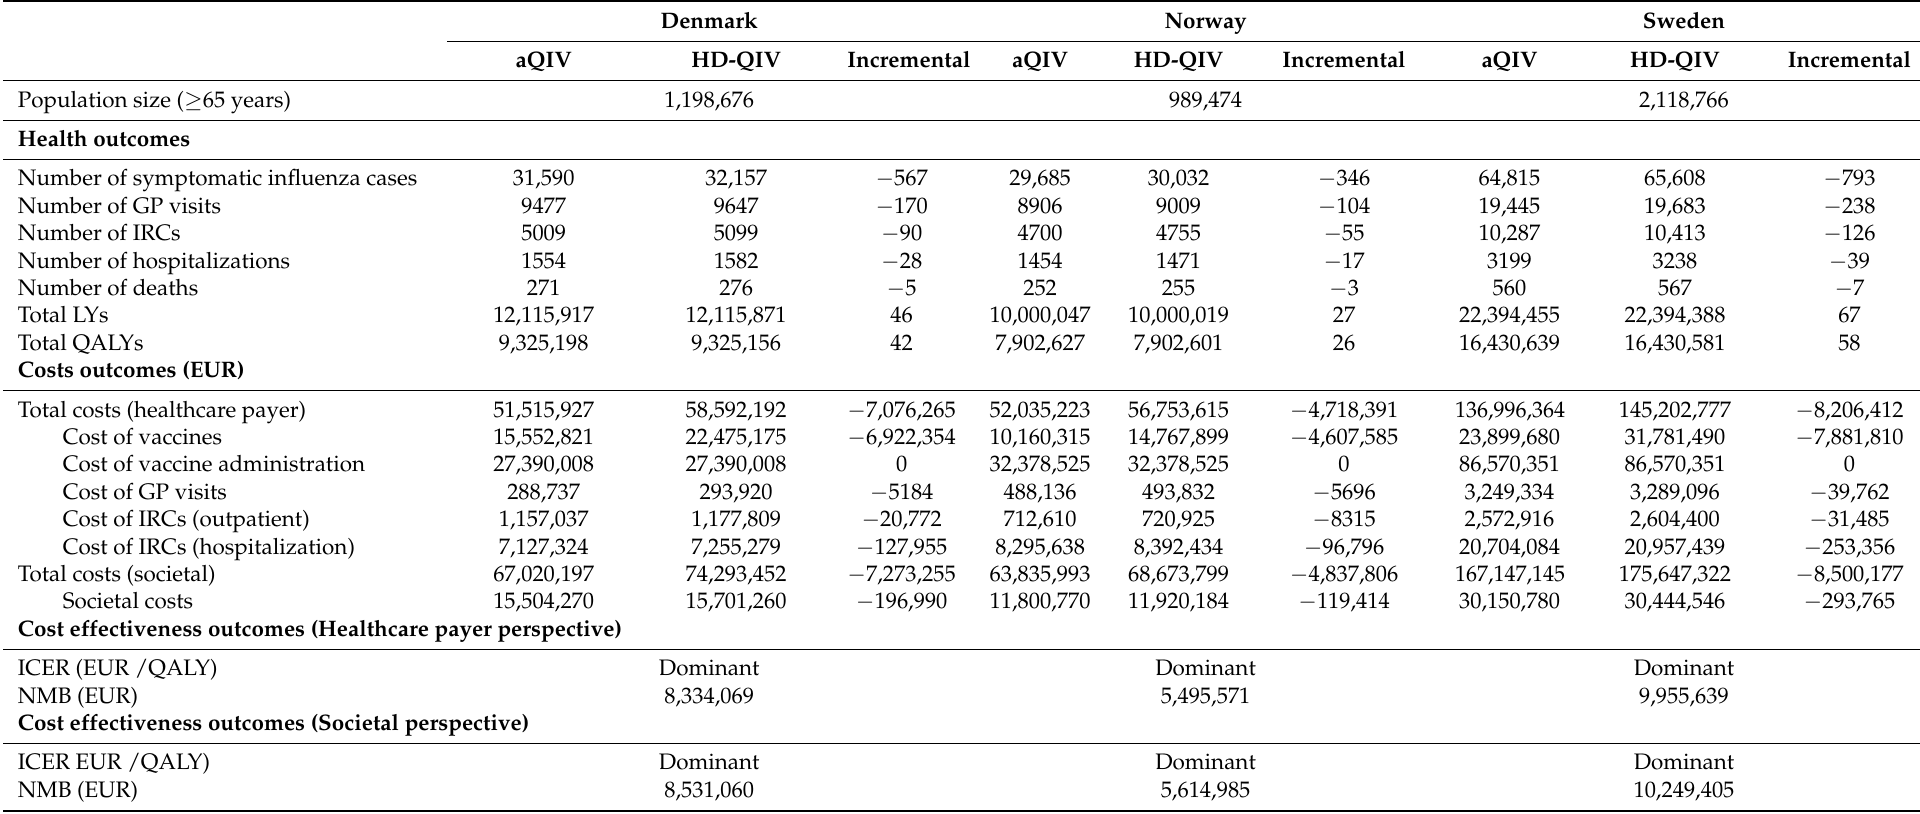
Table 5. Model results (aQIV vs. HD-QIV). Denmark Norway